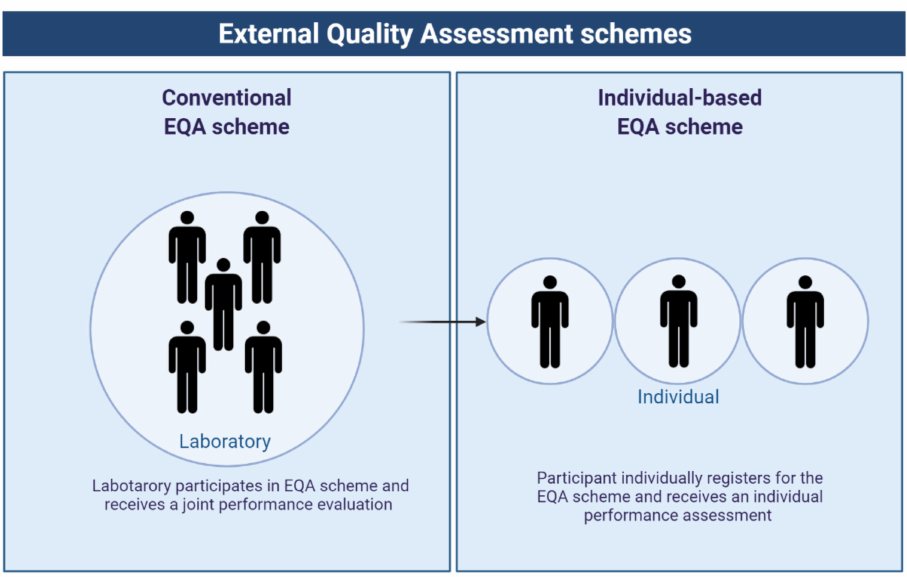
Figure 1. Shifting format of EQA schemes from laboratory-level assessment to individual-based assessment to fit the purpose of current research questions. Abbreviations: EQA, External Quality Assessment. Figure created with